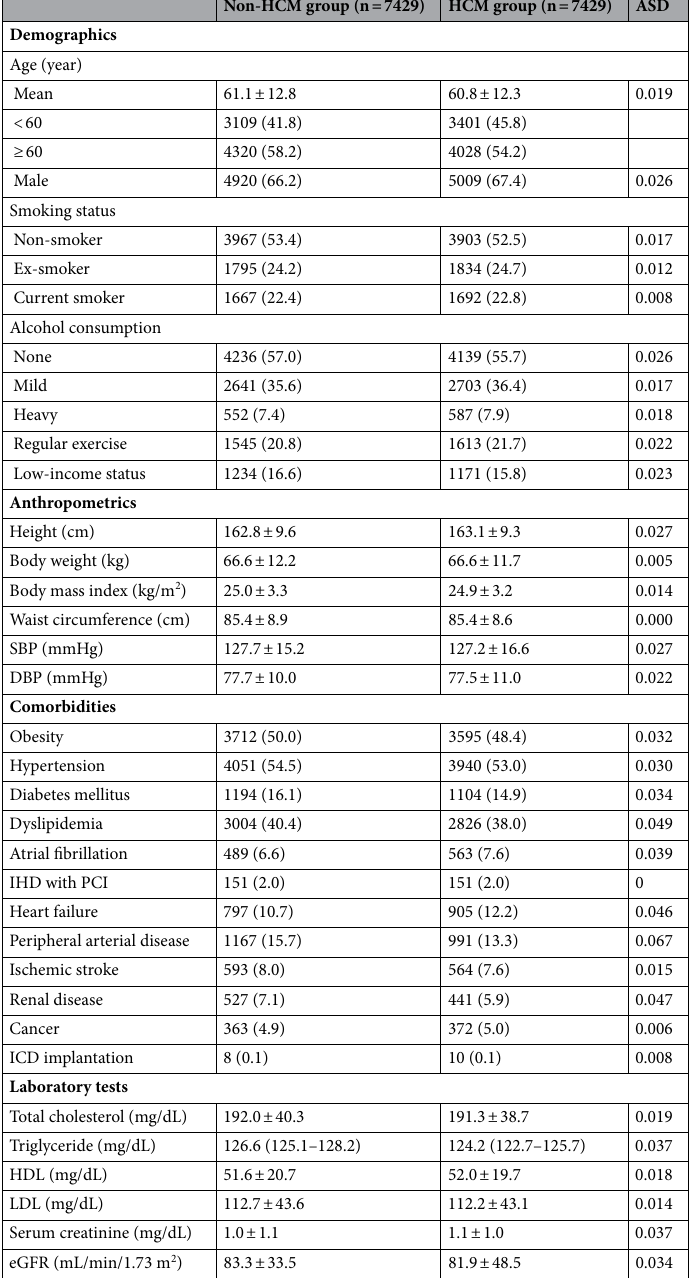
Table 1. Baseline characteristics of the study population after propensity score matching. Data are n (%) or mean ± standard deviation except for triglyceride (median with interquartile range). HCM